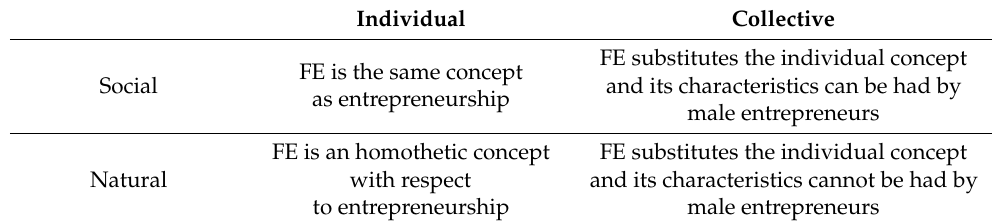
Table 1. Classification of female entrepreneurship